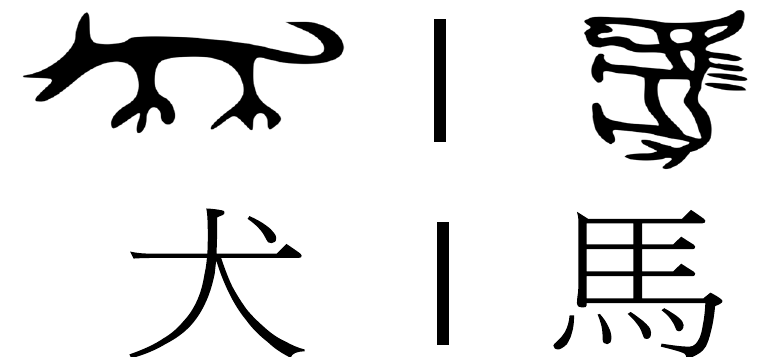
Figure 1. The Oracle Bone ( Above ) and Standard Chinese ( Below ) Script for the Characters for “Dog” ( Left ) and “Horse” ( Right ). (Source: Louis Komjathy). ( left ) and “Horse” ( right ) (source: Louis Komjathy).